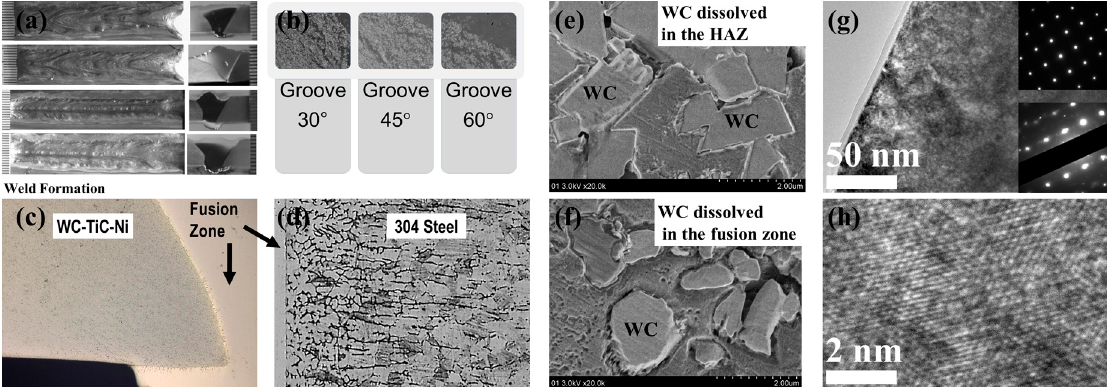
Figure 9. Metal-inert gas (MIG) welding of cemented carbide and 304 stainless steel. ( a – b ) Front-side weld formation and cross-sectional view of the corresponding joint (groove angles of 30°, 45°, and 60°). ( c – d ) Optical microstructures of the fusion boundary on the WC–Co side and 304 side. WC dissolving behaviors occurred ( e ) at the HAZ and ( f ) in the fusion zone. ( g ) TEM image and selected area electron diffraction (SAED) patterns showing the typical austenitic structure and ( h ) high-resolution TEM image showing the corresponding crystal lattice. Reproduced or adapted from [99], with permission from Springer, 2018.